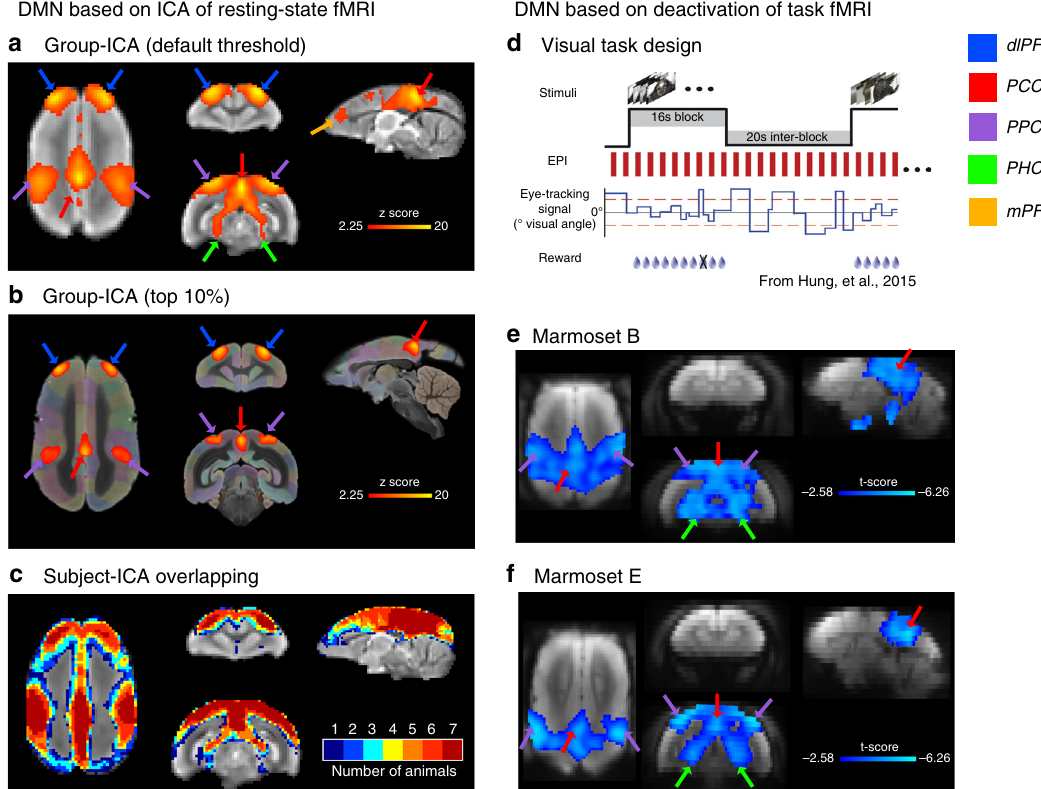
Fig. 1 Regions of the DMN largely overlap negative responding regions to task-based fMRI. a Putative regions of the DMN were extracted from group-wise ICA of resting-state fMRI data across seven marmosets, overlaid on mean EPI images. The ICA component was thresholded at a level of 0.5 using a mixture model and an alternative hypothesis testing approach (default of the FSL-Melodic). Surface rendering of this ICA map is presented in Fig. 2a. b Peak regions of the DMN component (the top 10% voxels), overlaid on a template from the NIH Marmoset Brain Atlas 11 . c Subject-speci fi c ICA was performed and putative DMN regions were extracted from each marmoset using the default threshold, which are shown in Supplementary Fig. 1. An incidence map of the overlap of these subject-speci fi c ICA components is presented. d Block-design paradigm for the visual stimulation task-based fMRI. Two marmosets ( e , f ) were trained to attend to visual stimuli presented in 16-s long blocks on an LCD screen, during which different images were randomly presented in each block 12 . The 16-s long blocks were intercalated by 20-s resting blocks during which the screen was blank (gray). Regions that deactivated during the stimulus block relative to the blank screen are presented (stimulus — resting, p < 0.05, Student ’ s t -test, corrected for multiple comparisons). dlPFC dorsal – lateral prefrontal cortex, PPC posterior parietal cortex, PCC posterior cingulate and medial parietal cortex, PHC parahippocampal cortices, mPFC medial prefrontal cortex. Arrows identify the different regions according to the color